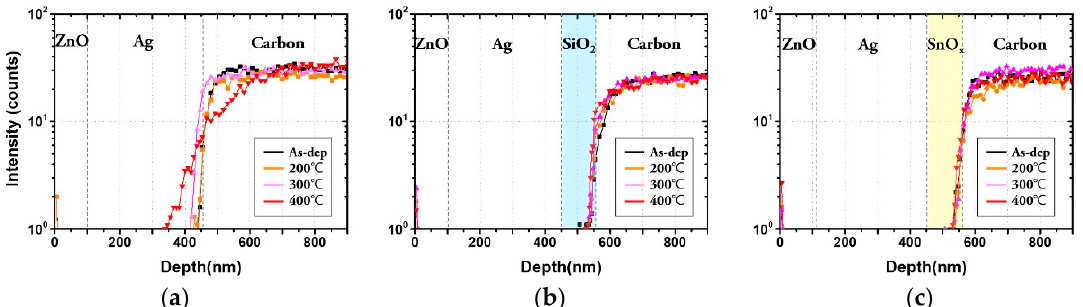
Figure 4. Di ff usion of carbon by secondary-ion mass spectrometry (SIMS) in ( a ) ZnO / Ag / graphite sheet,